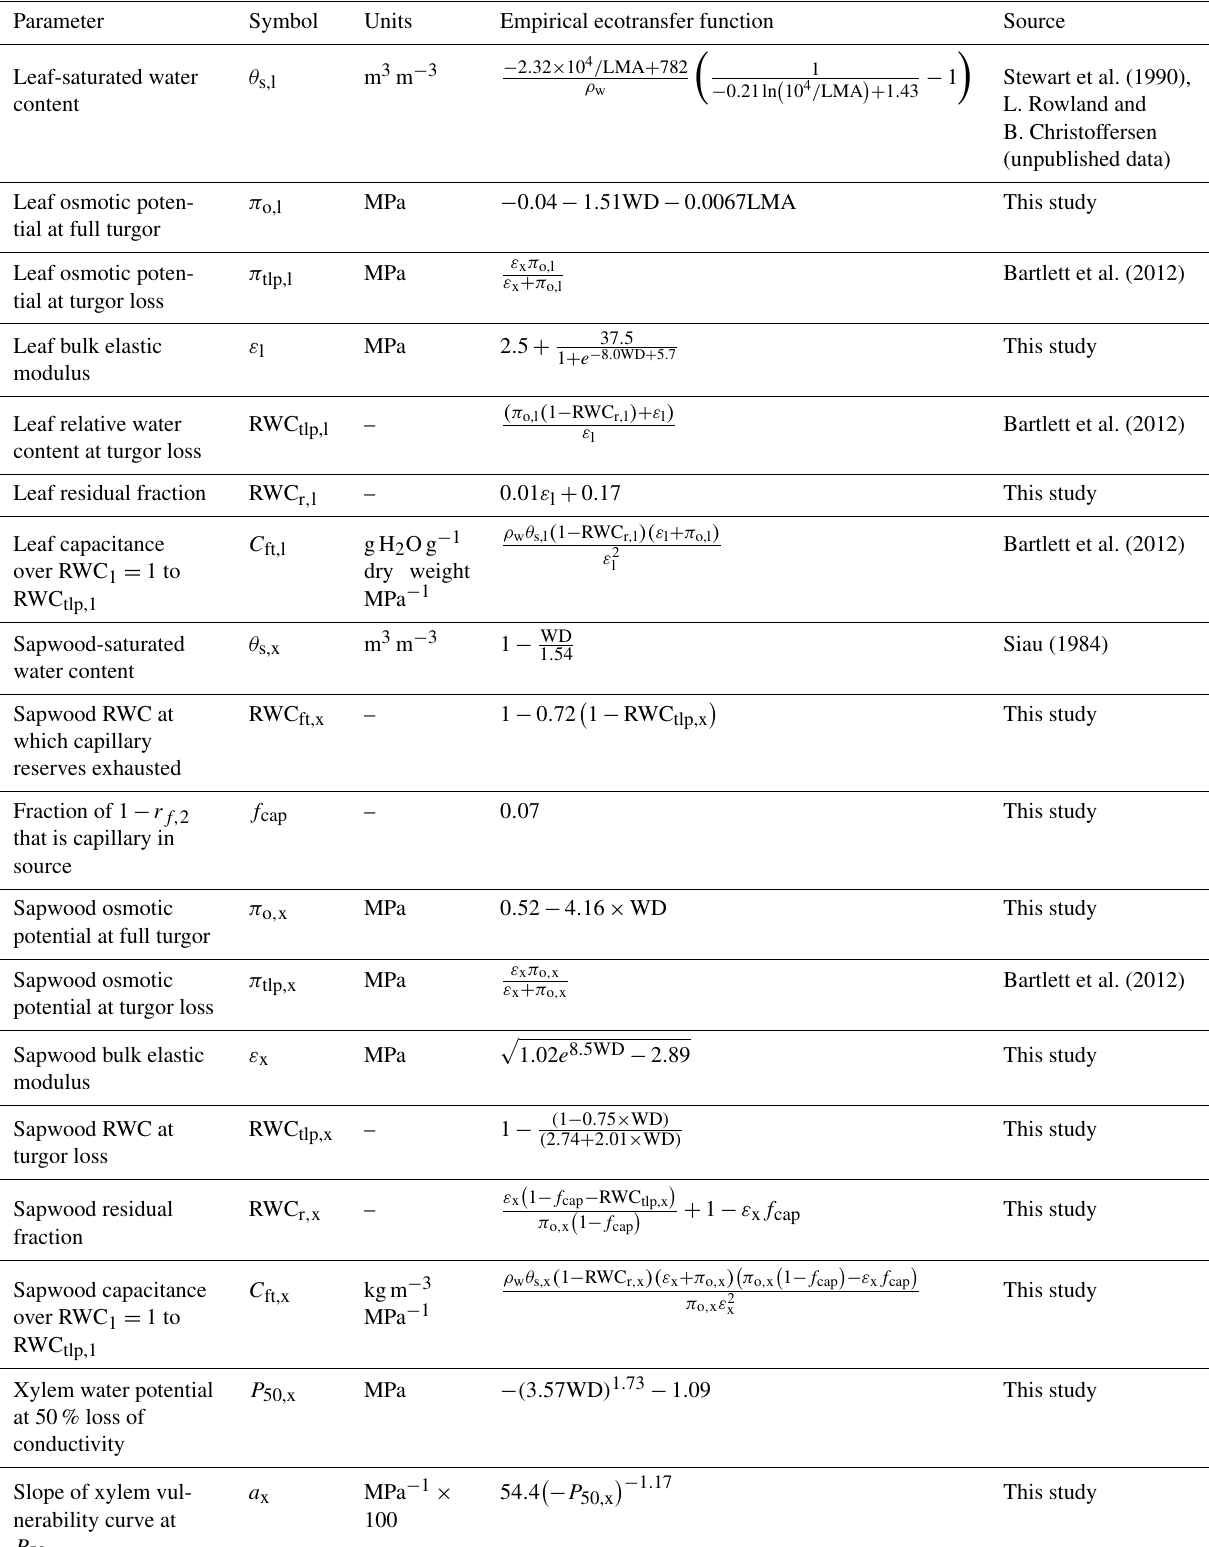
Table 2. Hydraulic traits used by the model. Resultant empirical “ecotransfer” function which estimates hydraulic traits as a function of input traits and its corresponding